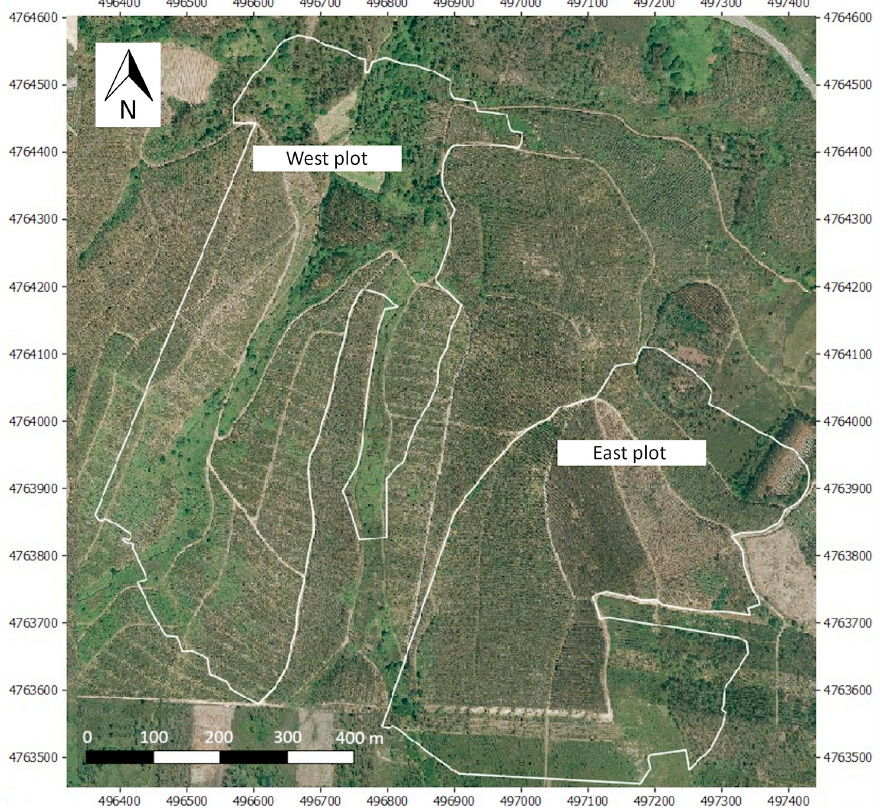
Figure 1. Location of the studied plots (aerial image from Plan Nacional de Ortofotografía Aérea (PNOA) 2016, https://pnoa.ign.es).